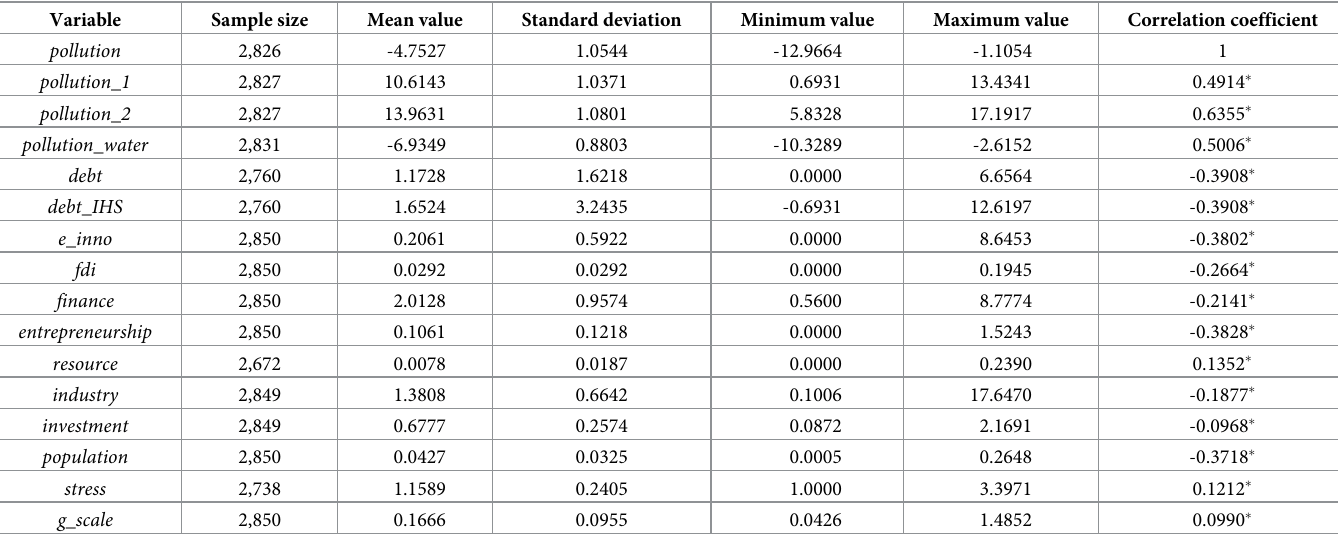
Table 2. Statistical characteristics of the